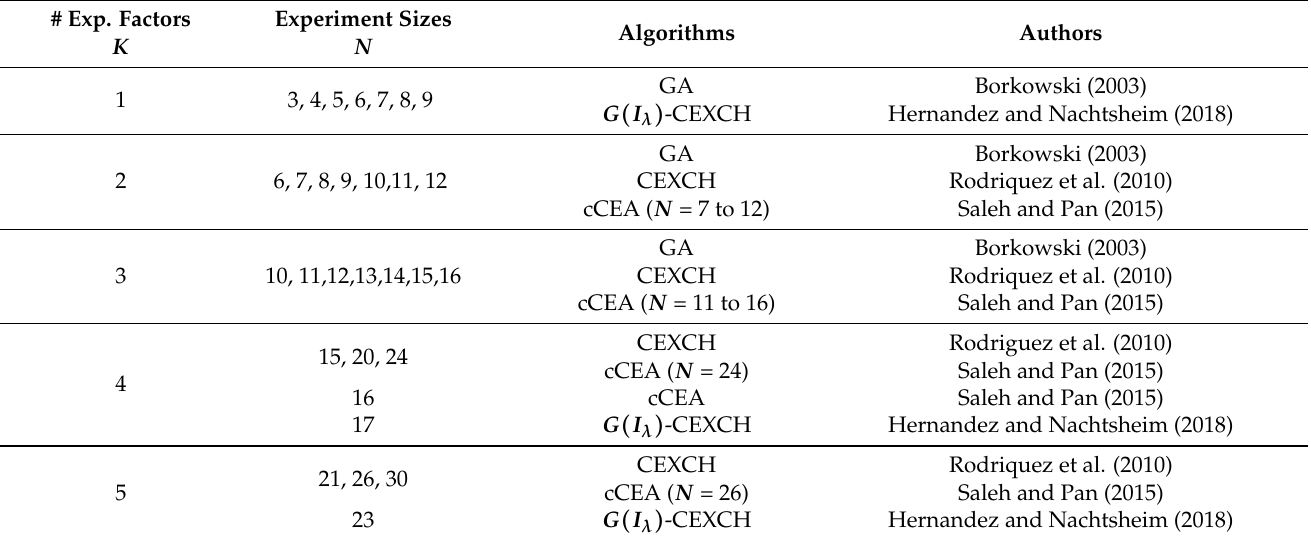
Table 1. Summary of design scenarios, algorithms, and authors who have addressed the exact G -optimal design problem for the second order RSM model in the last 20